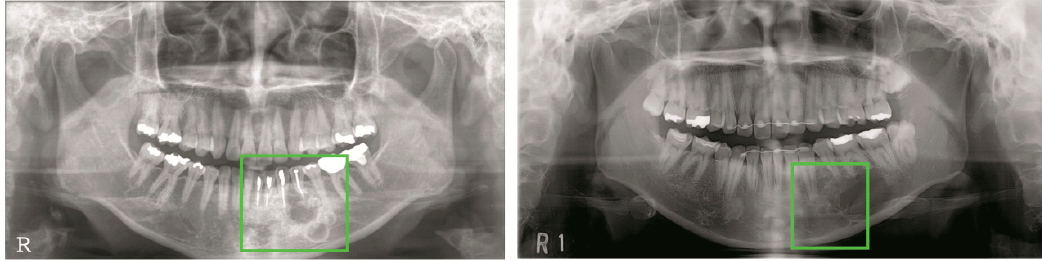
Figure 6. Small objects concentrated within a region of interest (ROI).